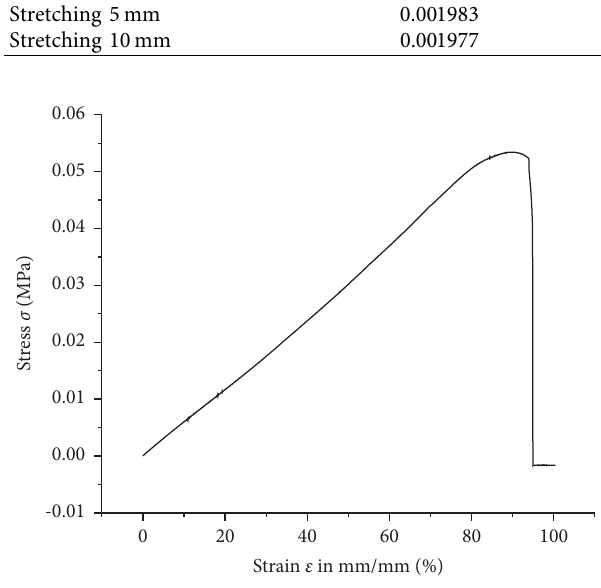
Figure 5: Stress and strain relationship of composite gels under static tension.